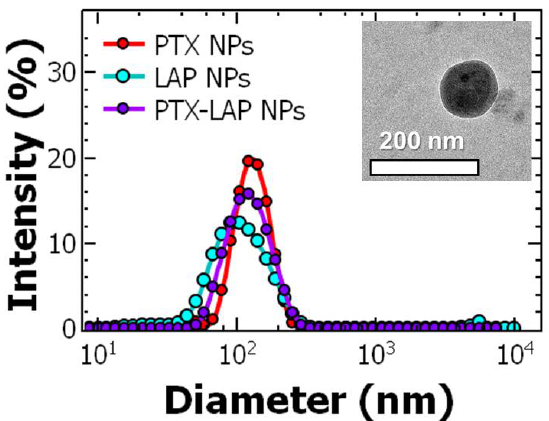
Figure 1. Representative dynamic light scattering results of uniform (red) paclitaxel nanoparticle (PTX NPs), (blue) lapatinib nanoparticle (LAP NPs), and (purple) co-loaded paclitaxel–lapatinib nanoparticle (PTX–LAP NPs) samples produced at ~100 nm (each DLS curve is the average of n = 4 measurements). Representative transmission electron microscopy (TEM) image of PTX–LAP NPs (scale bar = 200 nm) as inset.